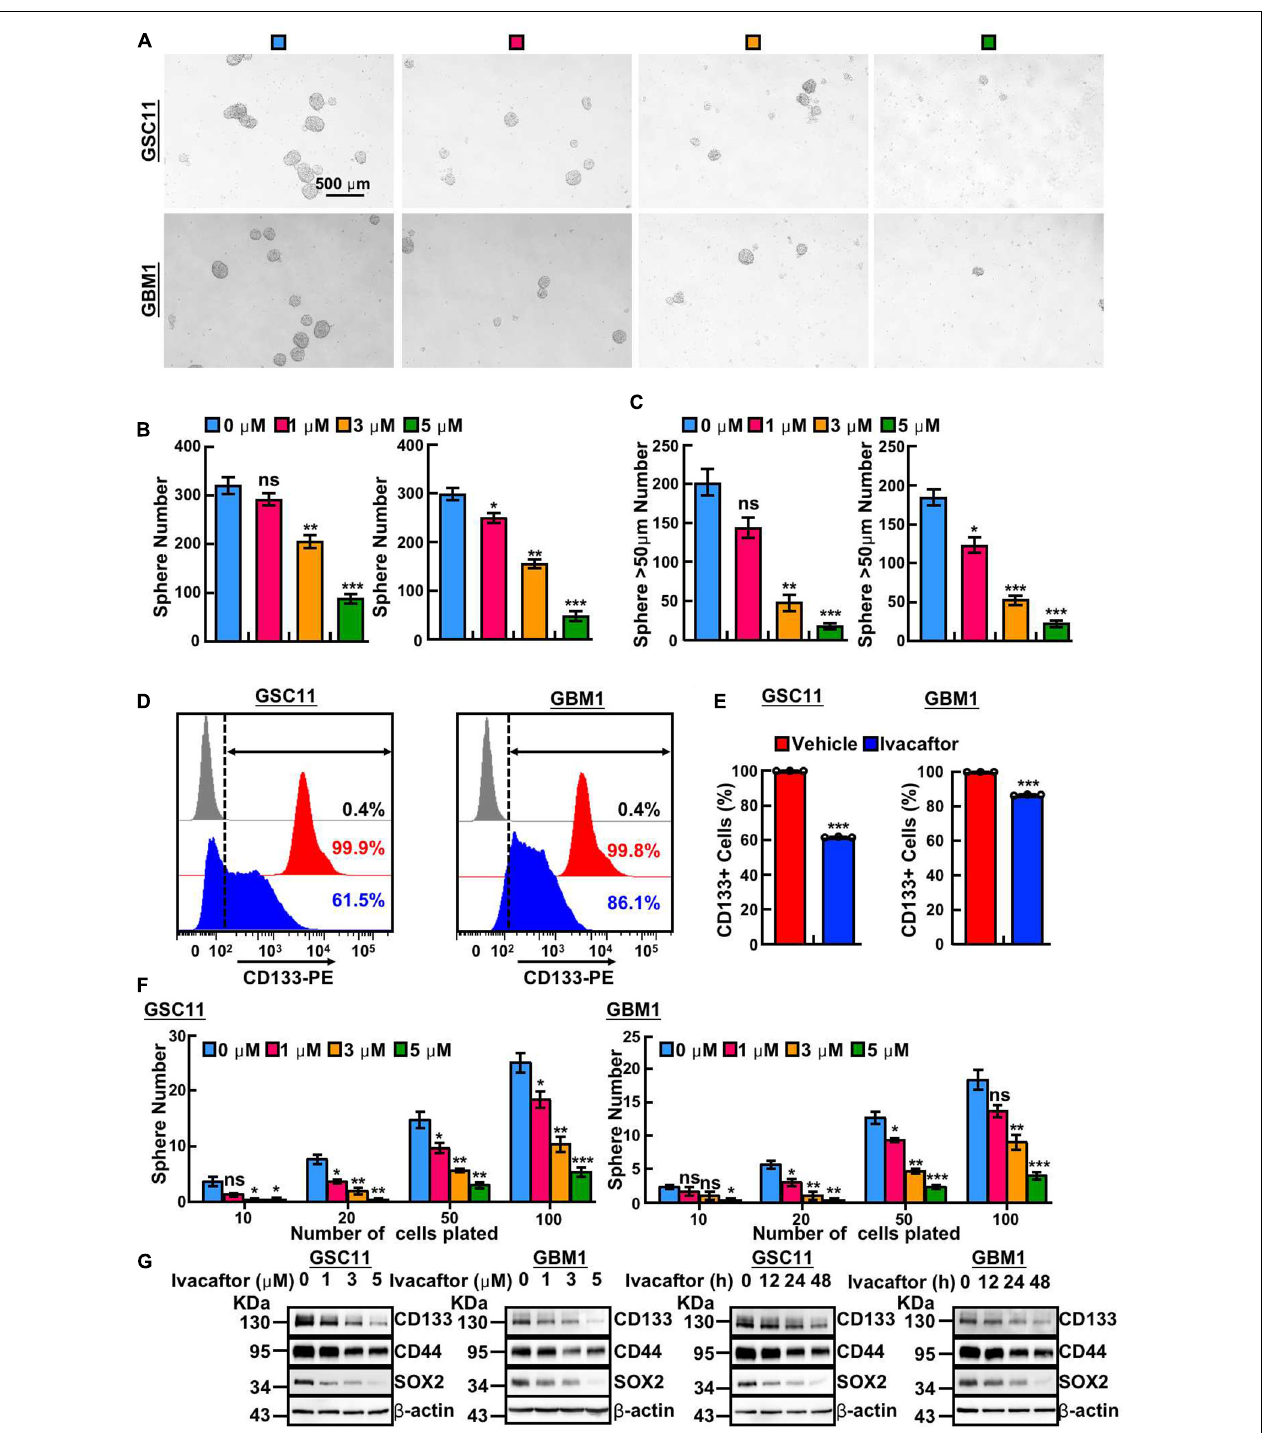
FIGURE 2 | Ivacaftor inhibits GSCs self-renewal ability. (A) Representative images of tumor sphere derived from GSC11 (top panel) and GBM1 (down panel) treated with indicated concentrations of ivacaftor. Scale bar: 500 µ m. (B) Tumor sphere formation ability was significantly attenuated by treating GSC11 (left panel) and GBM1 (right panel) cells with different concentrations of ivacaftor. (C) Ivacaftor treatment significantly decreased GSC11 (left panel) and GBM1 (right panel) larger tumor sphere (diameter larger than 50 µ m) formation ability. (D,E) CD133 membrane accumulated positive cells in GSC11 and GBM1 were decreased after treatment with 5 µ M ivacaftor for 48 h determined by flow cytometry assay. (E) Quantification data for (D) . (F) Effects of ivacaftor in indicated cells evaluated by in vitro limiting dilution assay. (G) GSC11 and GBM1 cells self-renewal ability and stemness marker gene expressions were inhibited by ivacaftor via time- or dosage-dependent manner. Data are shown as means ± SEM, * P < 0.05; ** P < 0.01; *** P < 0.001; t -test.